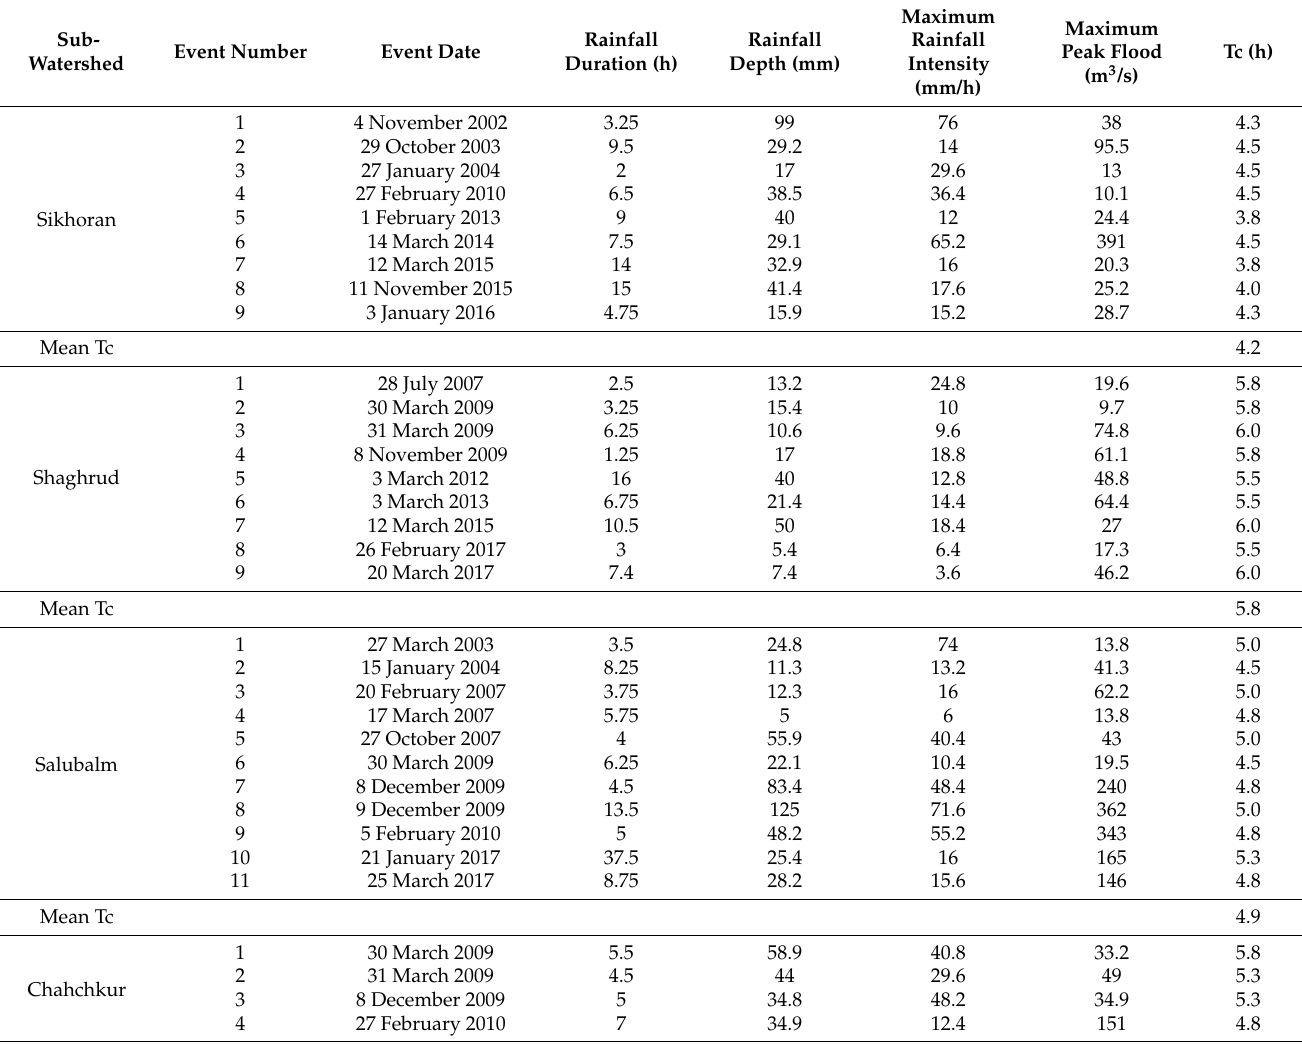
Table 5. Values of T C in sub-watersheds determined from the graphical